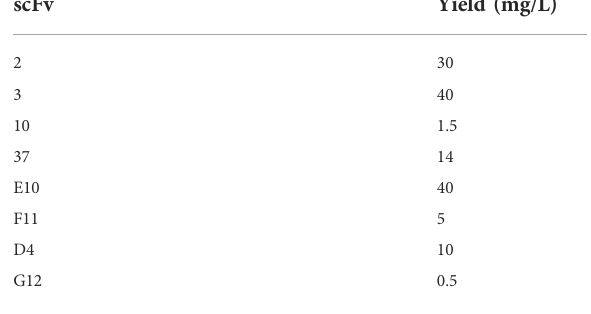
TABLE 1 ScFv production yields in E. coli